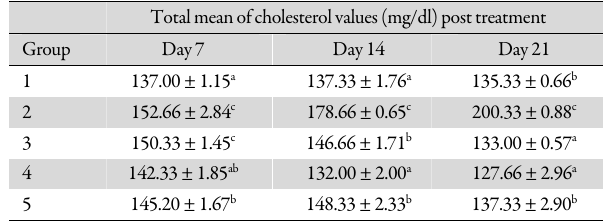
Different superscript along the same column (across groups) indicate significant difference at p < 0.05